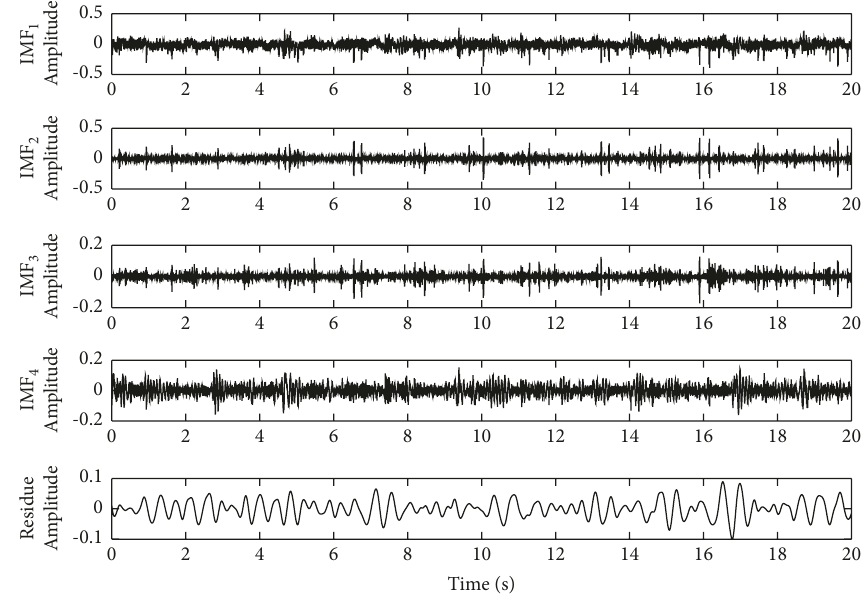
Figure 11: The decomposition results generated by EEMD of a vibration signal from class